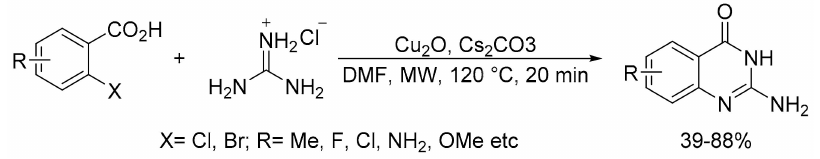
Scheme 46. Cu 2 O catalyzed microwave-assisted synthesis of quinazoline